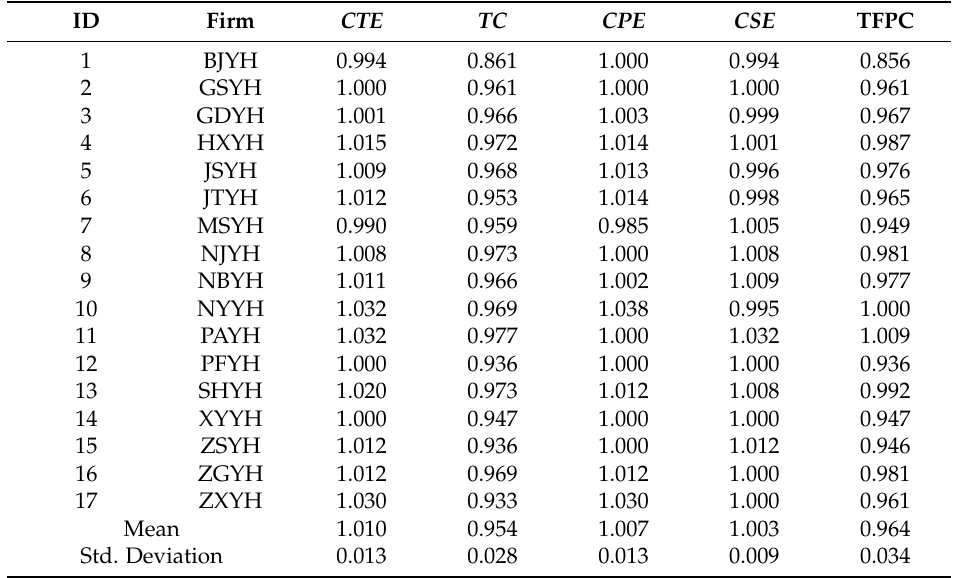
Table 3. The Malmquist total factor productivity index and its factors 1 (2012–2017, firm level).